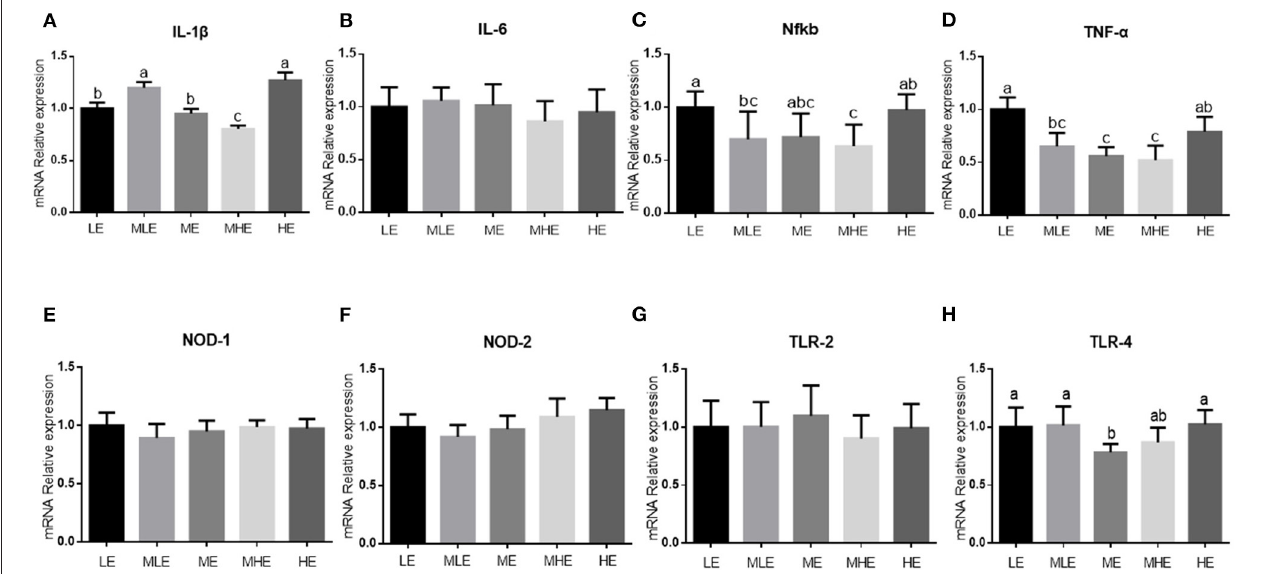
FIGURE 3 | The effects of dietary energy level on expression of hepatic genes related to inflammation in Yunnan semi-fine wool sheep. Real-time RT-PCR analysis for mRNA expression of hepatic genes including (A) IL-1 β ; (B) IL-6; (C) NFKB; (D) nucleotide-binding oligomerization domain 2 (NOD2); (E) Toll-like receptors 2 (TLR2); (F) Toll-like receptors 3 (TLR3); (G) Toll-like receptors 4 (TLR4); and (H) TNF- α . Values with different letters were significantly different ( p < 0.05).